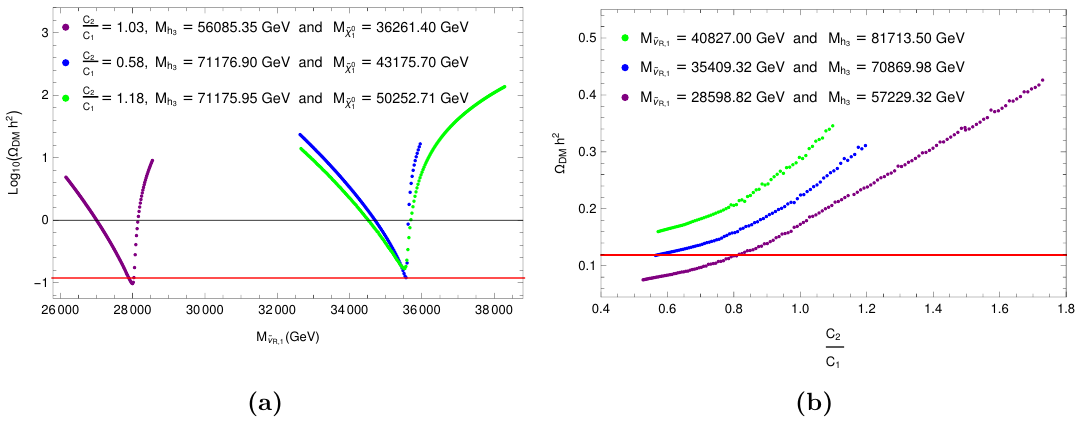
Figure 4. As in (cid:12)gure 3, but for the U(1)